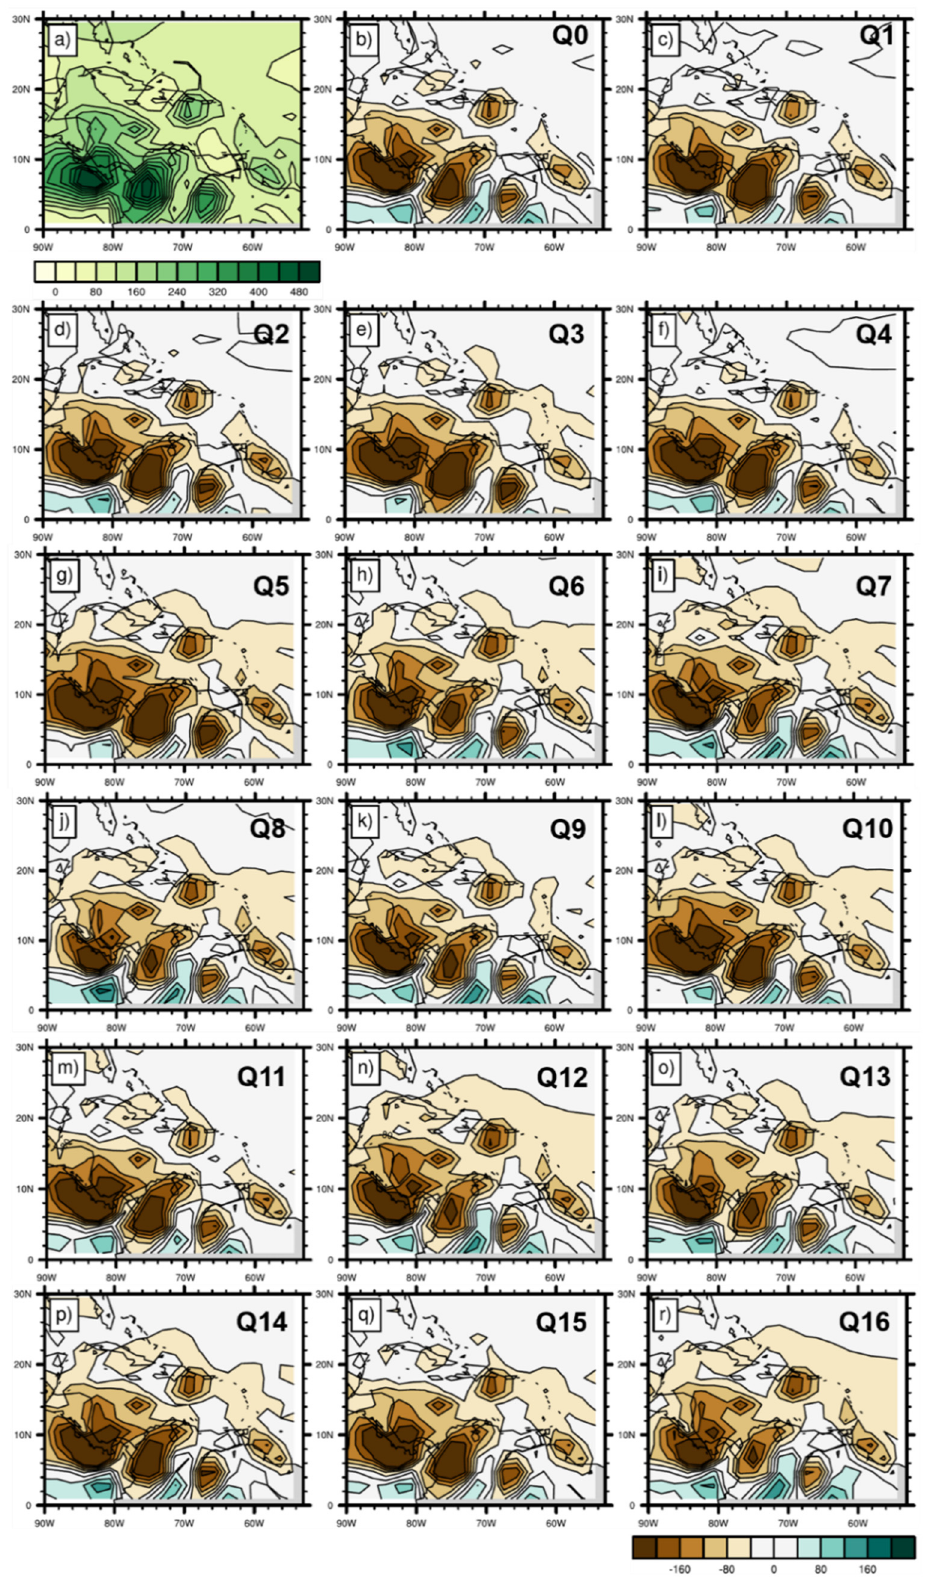
Figure 4. Annual plots of precipitation averaged over the period 1960–1990 ( a ) in mm per month. Observed ( b – r ) percentage difference between observation and respective PPE.